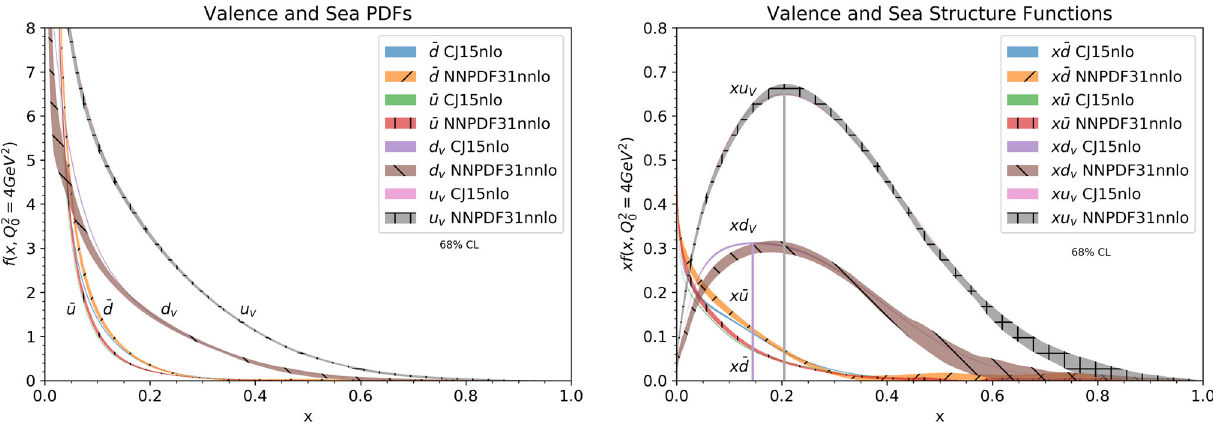
[36,37] are used in the calculation. Similar features are also observed for other modern PDF parameterizations